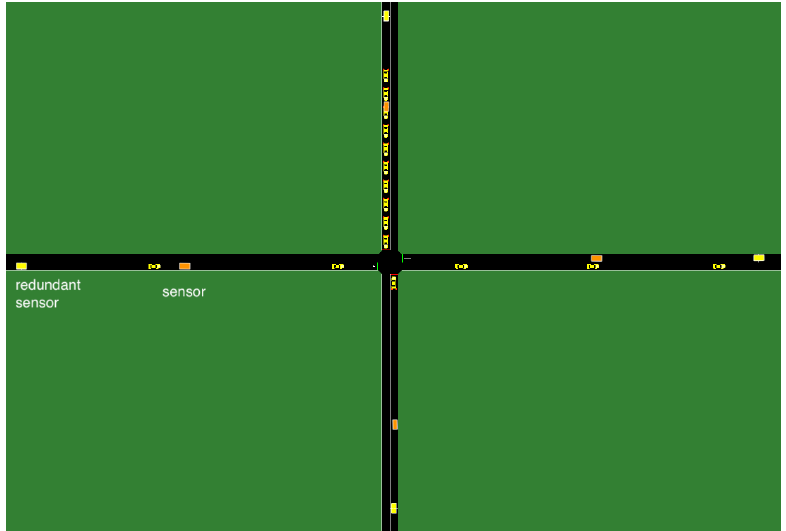
Figure 5. Each intersection in the 3-by-3 grid. For illustration, a critical and a redundant sensor are shown in the figure. For each lane, a second redundant sensor is placed with twice as much distance as the distance between the first redundant sensor and the critical sensor. All 8 total redundant sensors are used to predict the value of a